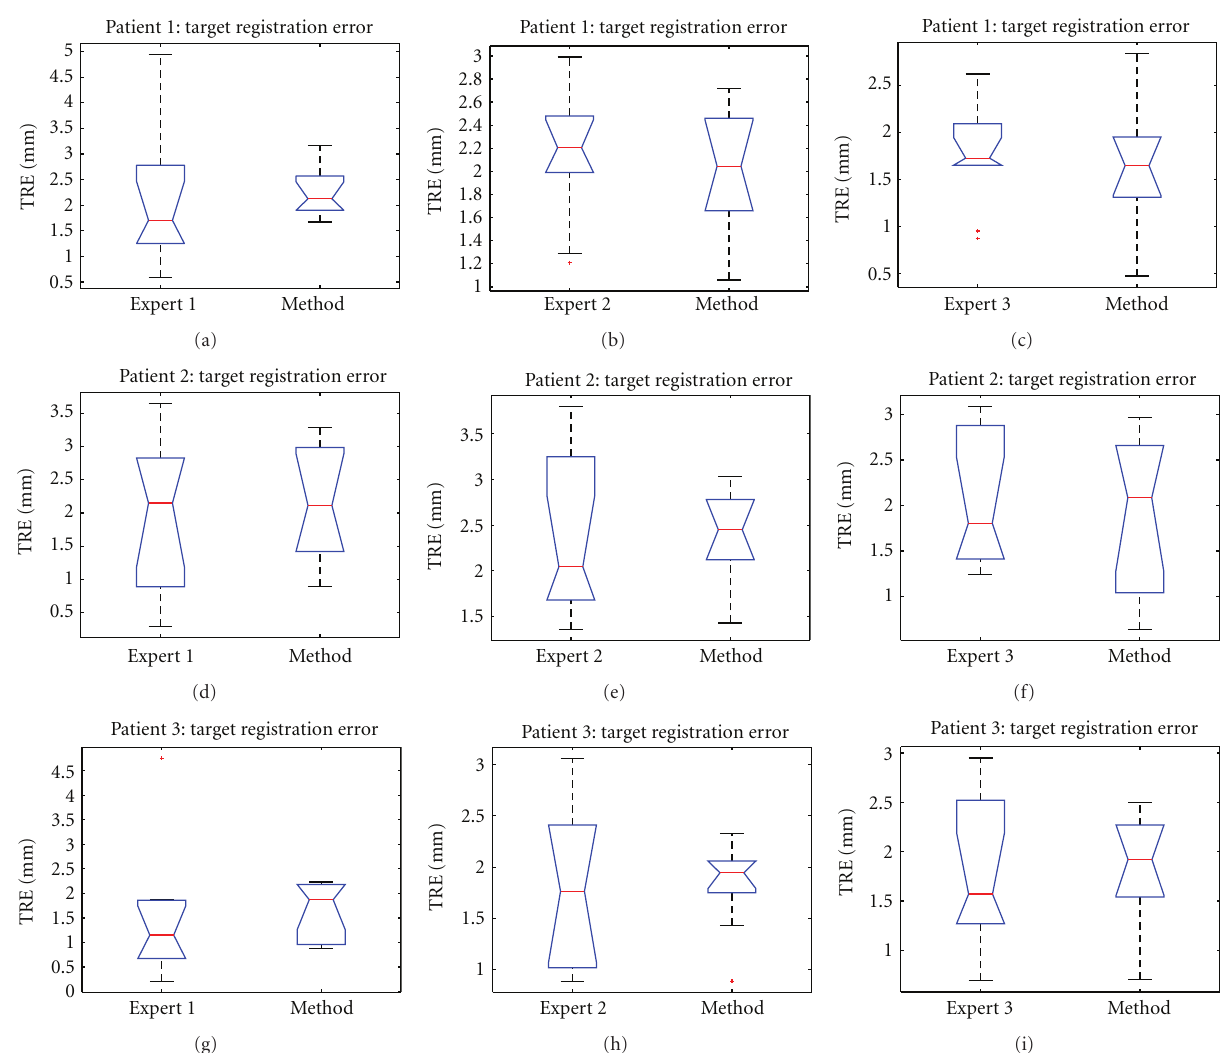
Figure 9: Target Registration Error (in mm) estimated by all experts for the each patient